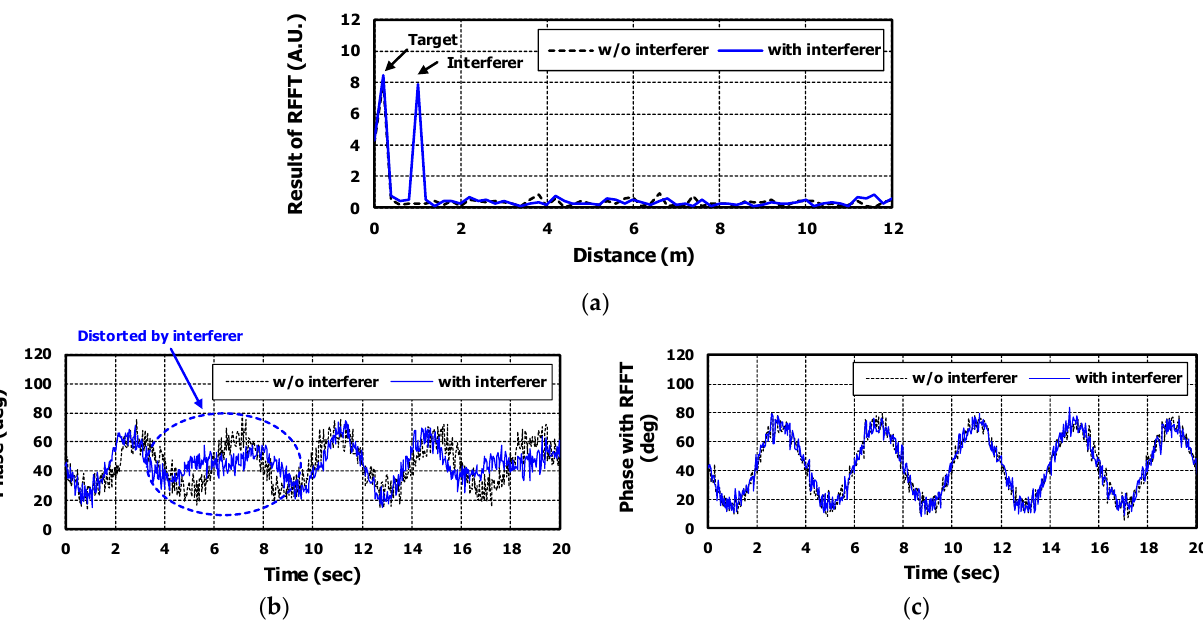
Figure 6. The simulation results for target information based on Table 1. The black dashed lines are results of the case without interferer and the blue solid lines are results of the case with interferer. ( a ) is the distance information of target and interferer obtained by range – FFT. ( b ) is the phase signal without applying range – FFT and ( c ) is the phase signal with applying range – FFT.